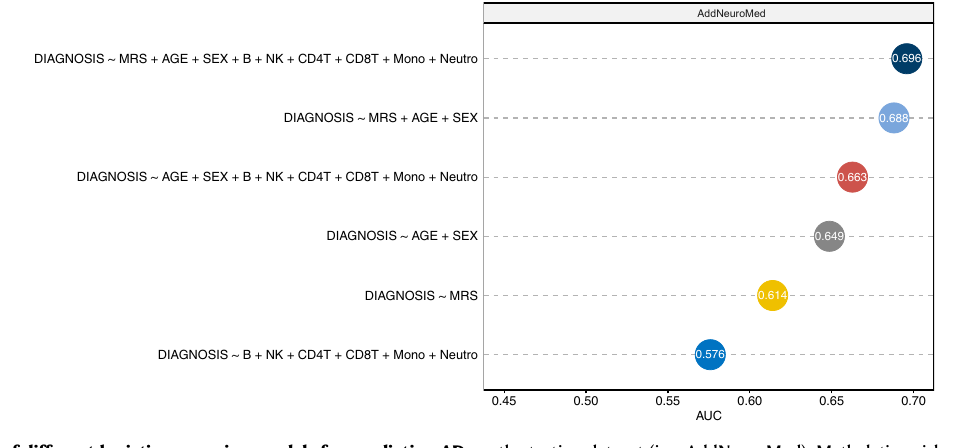
the testing dataset (i.e., AddNeuroMed). Methylation risk score (MRS) was com- puted as the sum of methylation beta values for these 91 CpGs weighted by